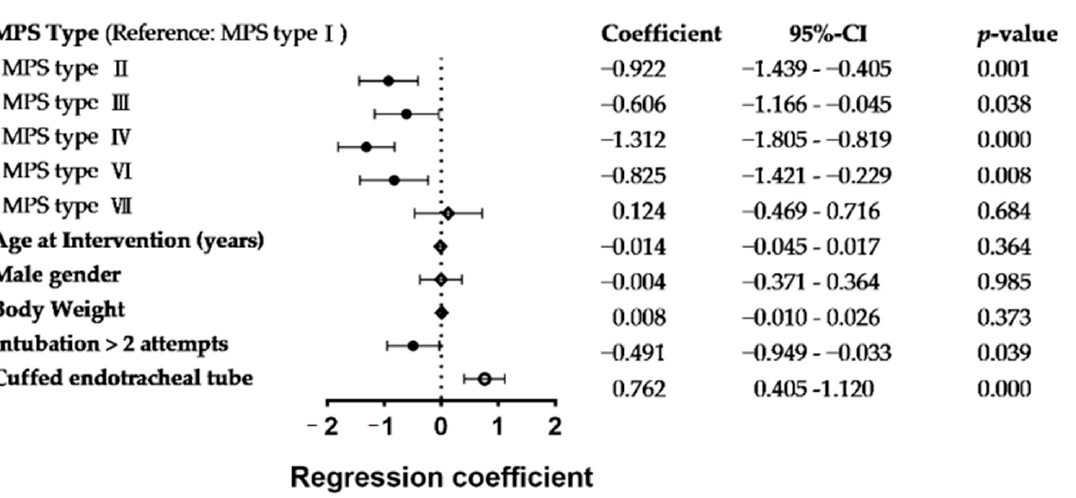
Figure 3. Multivariable linear regression analysis of the independent factors resulting in the differ- ences of endotracheal tube size between the predicted and actual size: a forest plot illustrates the extent of discrepancy on a linear scale; the diamonds/dots and lines indicate the regression coefficient with the 95% confidence interval (95% CI); solid round dots indicate statistically significant with negative effect, open diamonds indicate insignificant findings, open round dot indicate statistically significant with positive effect.